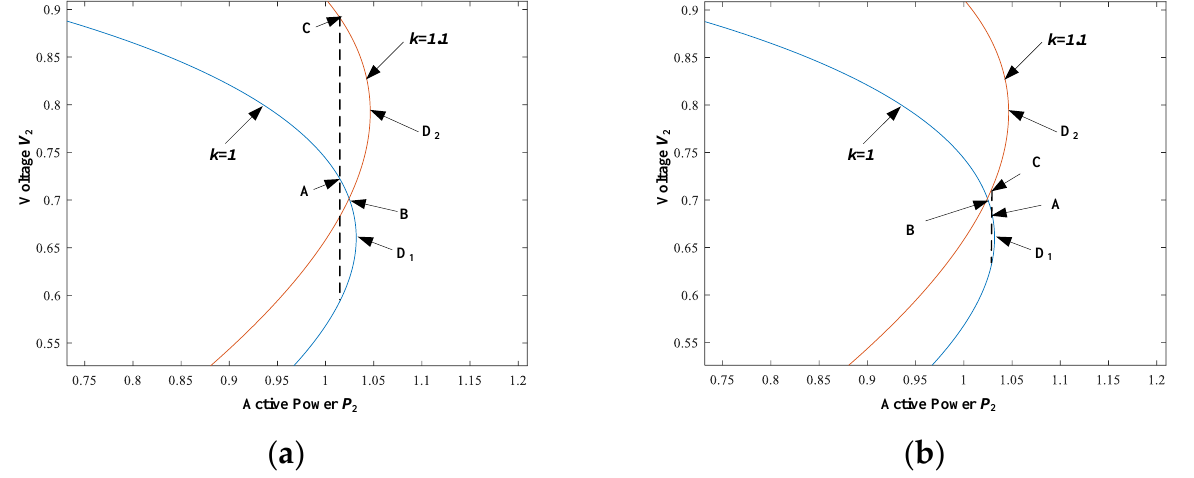
Figure 6. Positive voltage regulating effect of OLTC transformer. Point B is the intersection of the two P-V curves.